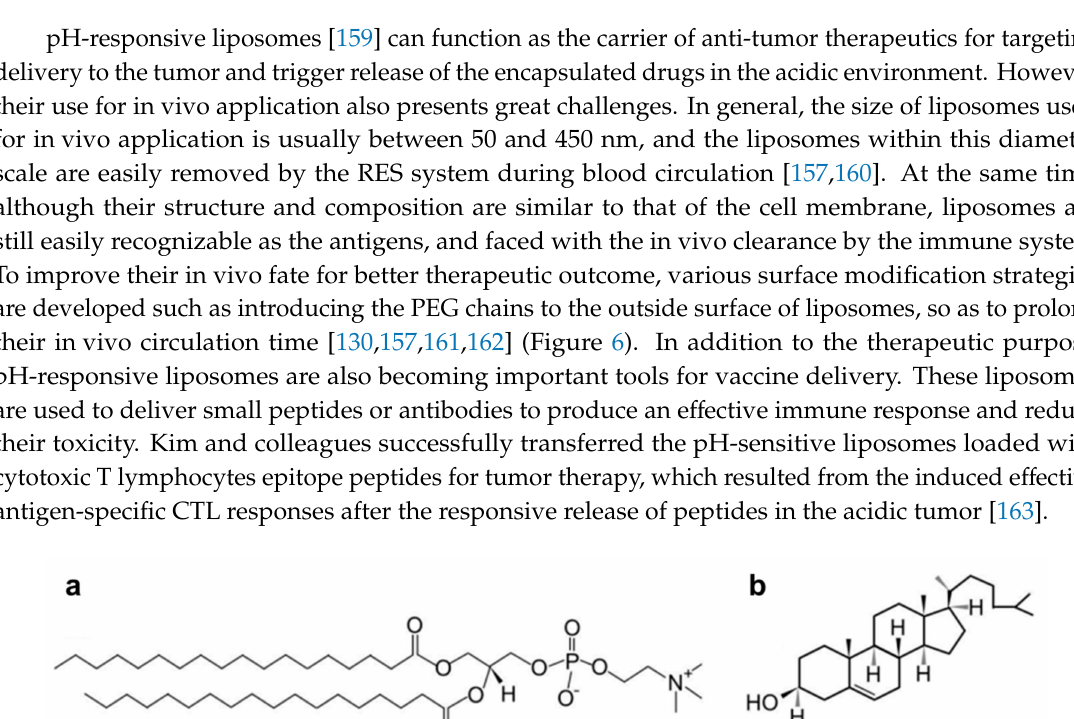
Figure 5. Classification of liposomes based on the lamellarity: Multilamellar Vesicles (MLV) with many lipid bilayers ranges from 1–5 µ m in size. Large Unilamellar Vesicle (LUV) is about 100–250 nm with single lipid bilayer. Small Unilamellar Vesicles (SUV) with size range 20–100 nm consists of a single phospholipid bilayer (reused with modification) [157].